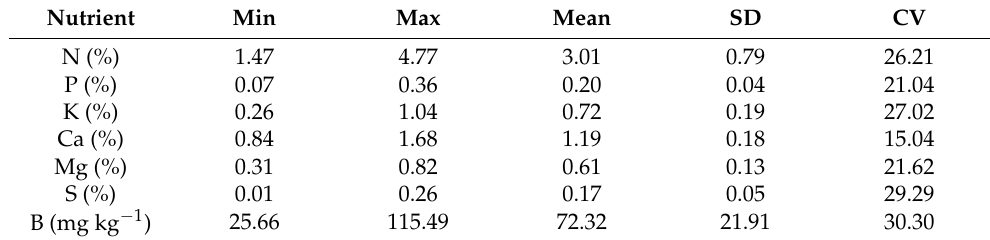
Table 3. Descriptive statistics * for selected leaf nutrients (n = 67).